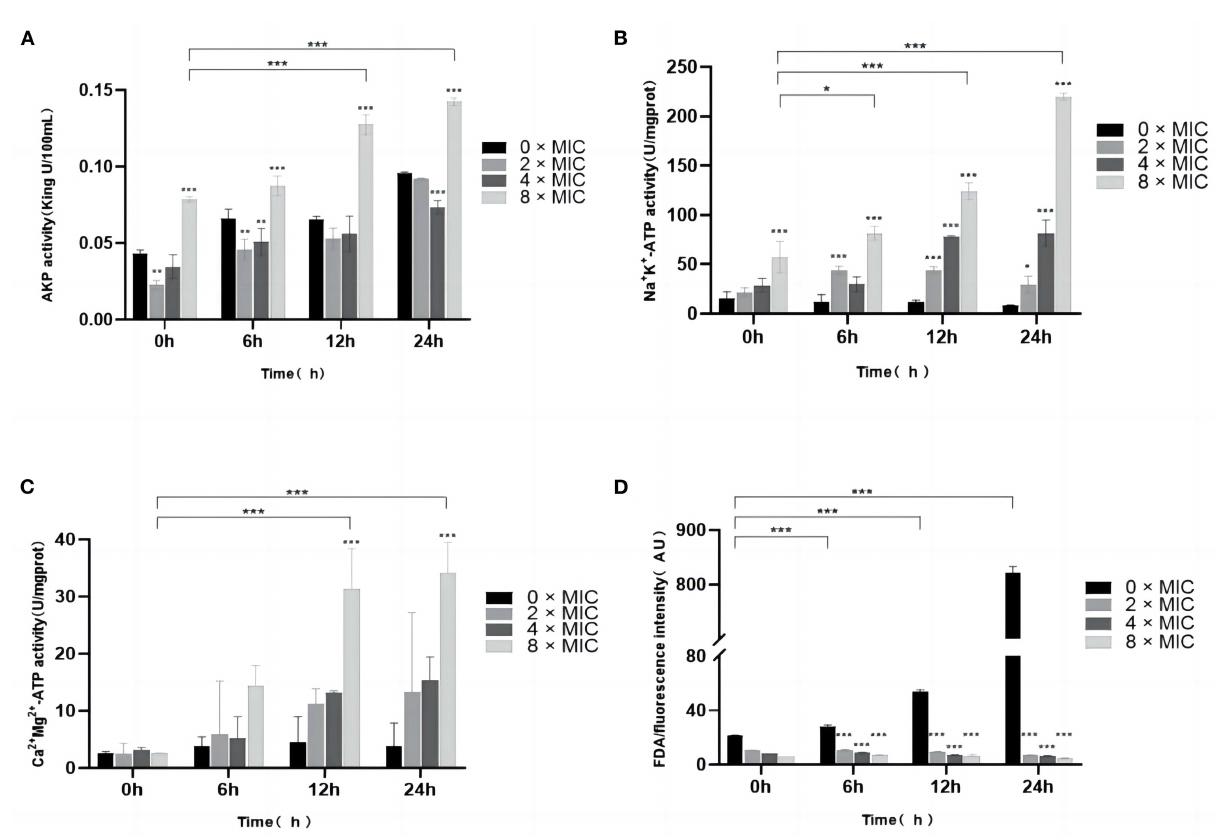
FIGURE3 Effects of SGCH on AKP and Na + K + , Ca 2 + Mg 2 + -ATP Activities and FDA of SA . (A) Impact of SGCH on AKP Activity of SA . (B) Determination of SA Na + K + -ATP activity by SGCH. (C) Determination of SA Ca 2 + Mg 2 + -ATP activity by SGCH. (D) Fluorescein diacetate (FDA) staining experiment. * p ≤ 0.05, ** p ≤ 0.01 , *** p ≤ 0.001